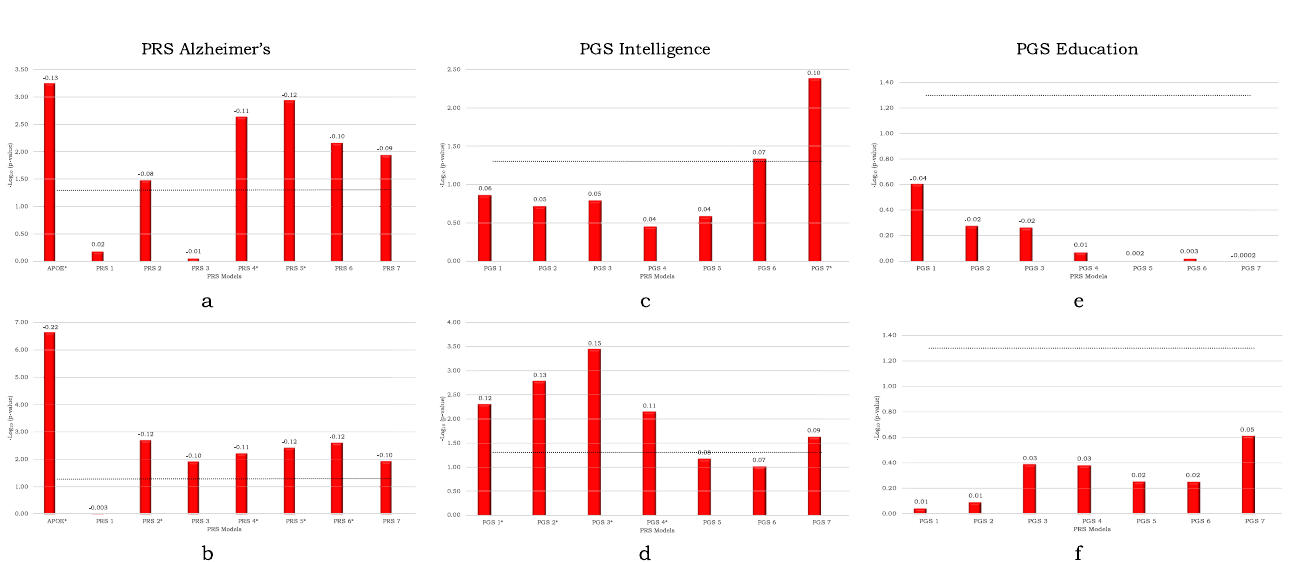
Figure 1. Associations of Polygenic Scores of AD, intelligence and education with cognition. ( a ) PRS-Alz association with the slope of longitudinal MMSE score. ( b ) PRS-Alz association with the intercept of MMSE score. ( c ) PGS-Int association with the slope of longitudinal MMSE score. ( d ) PGS-Int association with the intercept of MMSE score. ( e ) PGS-Edu association with the slope of longitudinal MMSE score. ( f ) PGS-Edu association with the intercept of MMSE score. The x-axis represents the 7 different PRS/PGS models at different p value thresholds based on the GWAS summary statistics (PRS1 ≤ 0.05, PRS2 ≤ 5e−3, PRS3 ≤ 5e−4, PRS4 ≤ 5e−5, PRS5 ≤ 5e−6, PRS6 ≤ 5e−7, PRS7 ≤ 5e−8). For PRS-Alz additional model was constructed with APOE alone (Represented on the x-axis as APOE). The models were adjusted for age, gender, education, baseline MMSE (not for the intercept), APOE ε2 and ε4 count and the top 10 principal components (PC) from the principal component analysis (PCA) on the entire set of genotype data. The y-axis shows the negative log of the p value for the significance of associations between PRS models with slope and intercept of longitudinal MMSE score. The values on the top of each bar show the effect size (beta-coefficient) of the association. The horizontal dotted line shows the p value threshold of 0.05. *These PRSs were significant after Bonferroni-correction at p value <